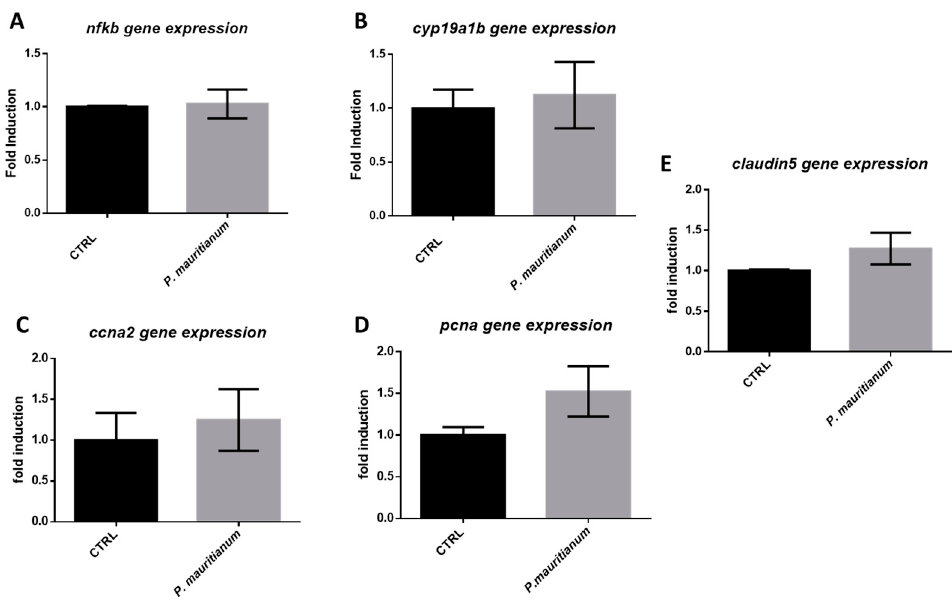
Figure 10. P. mauritianum has no effect on brain homeostasis in normal feeding conditions . RT-qPCR gene expression analysis of nuclear factor kappa B ( nf κ b ) a transcription regulator of inflammation ( A ), aromatase B gene ( cyp19a1b ) a brain plasticity marker ( B ), cyclin-a2 gene ( ccna2 ) and proliferating cell nuclear antigen ( pcna ) brain, two cell proliferation markers ( C , D ), and claudin 5, a tight junction gene involved in blood-brain barrier integrity ( claudin 5 ) ( E ). n = 3 pools of 2 brains. Bar graph: standard error of the mean (SEM). Student’s t -test.